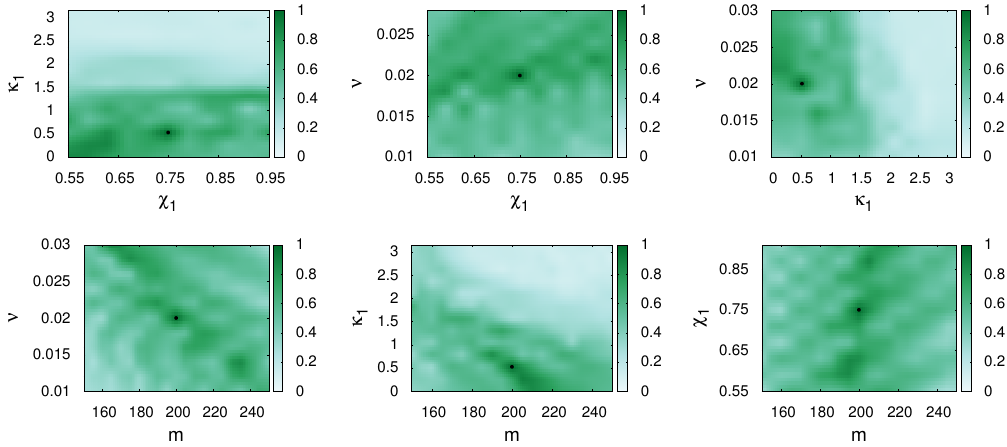
Figure 4. SpinTaylorT4 is matched with itself and and match values M are presented in different parameter planes ( κ 1 , χ 1 ), ( ν , χ 1 ), ( ν , κ 1 ), ( ν , m ), ( κ 1 , m ) and ( χ 1 , m ). The parameters of the first waveform (the template) are varied, while those of the second waveform (the signal, represented by a dot) are fixed as m = 200 M (cid:12) , ν = 0.02, χ = 0.75 and κ 1 = 0.5. The other parameters were chosen as f low = 10 Hz, ι = 0.5. Spins are precessing in this